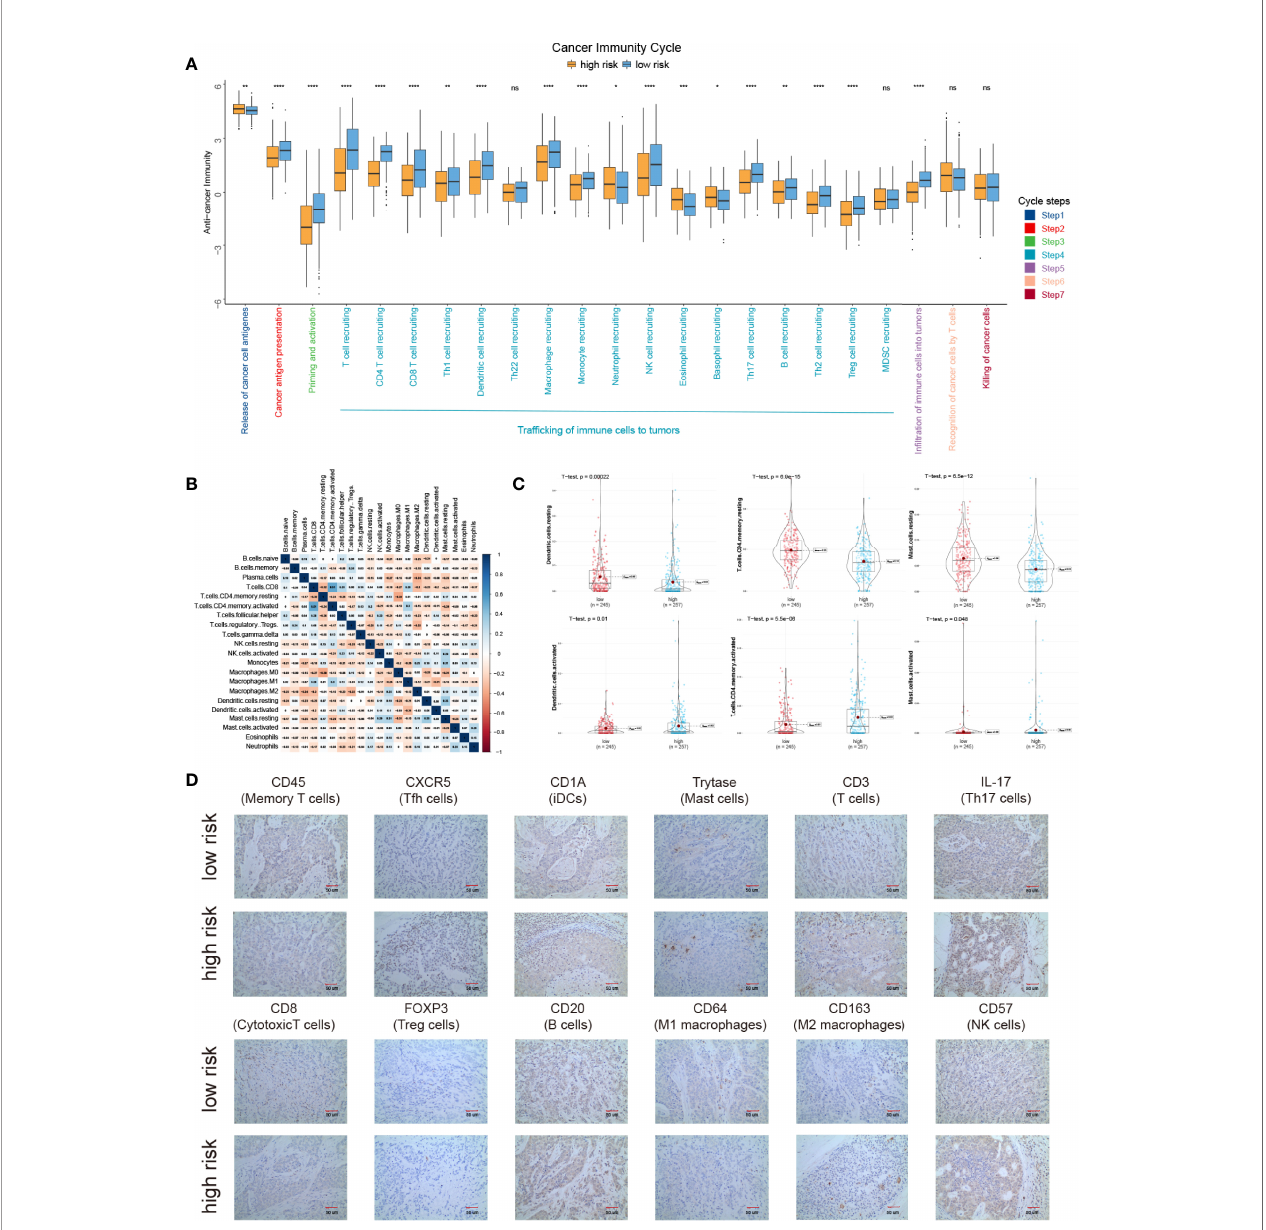
FIGURE 3 | The landscape of immune in fi ltration in high- and low-risk LUAD patients. (A) Cancer immunity cycles between low and high risk groups. (B) Correlation of the proportions of 22 different immune cell. (C) Signi fi cantly different immune cells between low- and high-risk groups. (D) Proteins expression of different immune cells between low- and high-risk groups. *P < 0.05, **P < 0.01, ***P < 0.001, ****P < 0.0001, ns P >